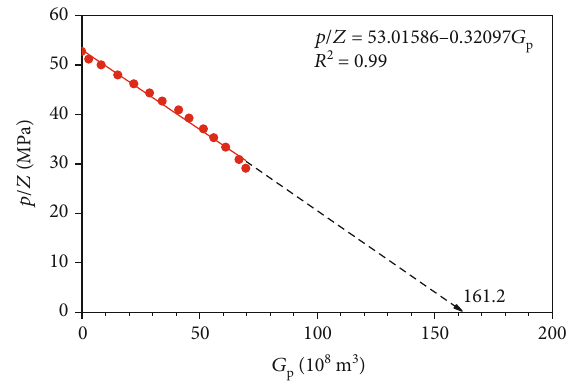
Figure 7: Reserves of Louisiana o ff shore gas reservoir calculated by the p / Z curve Table 4: Producing history of X gas reservoir.